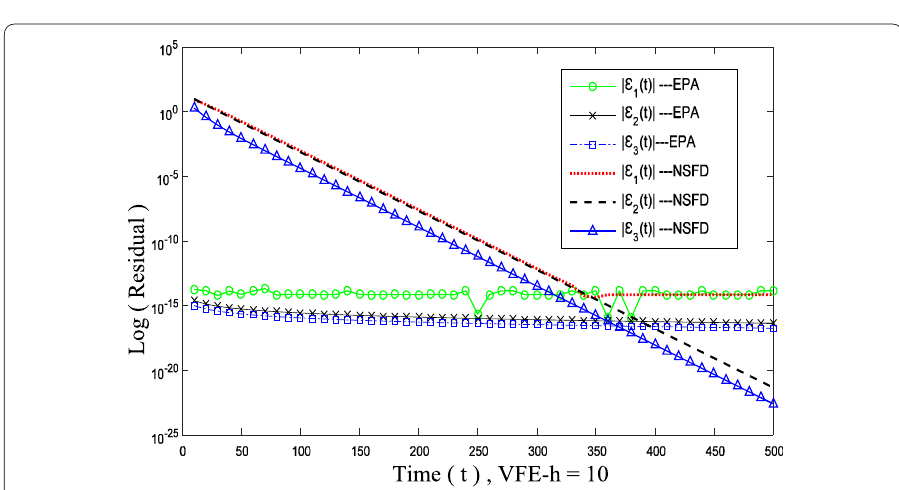
Figure 12 Absolute residuals of EPA and NSFD solutions at VFE for h = 10